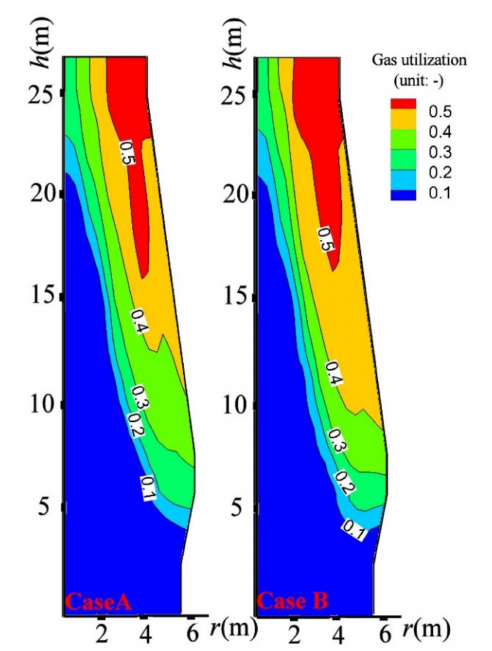
Figure 11. Profiles of local gas utilization in cases A and